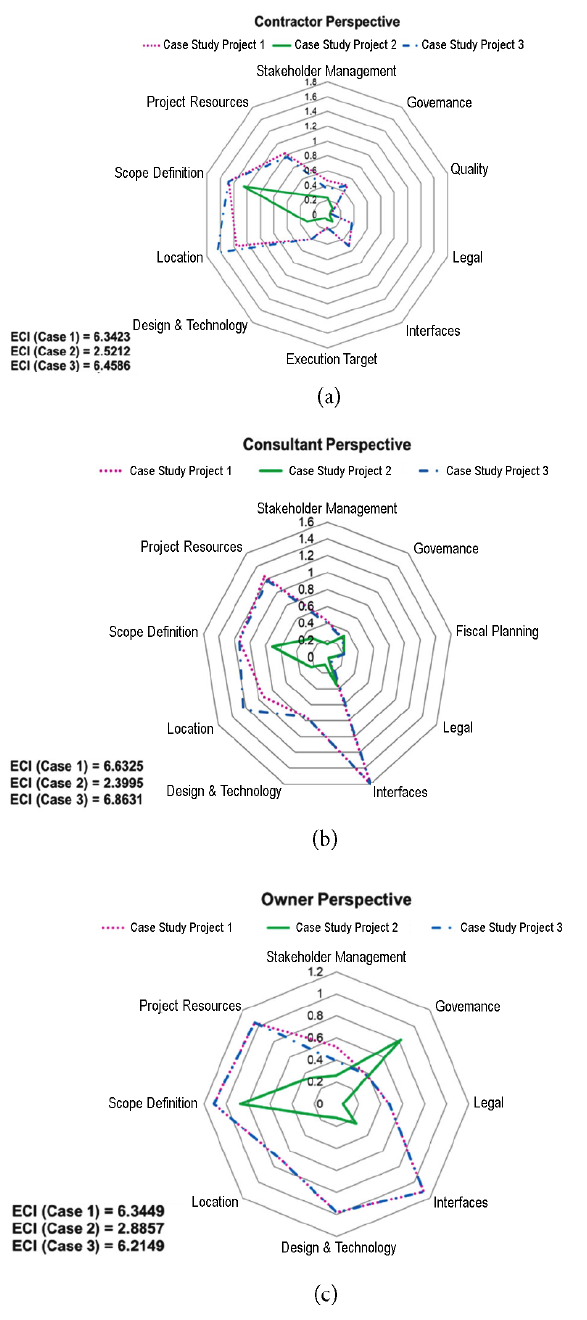
Figure 6. Comparison of weighting of complexity categories in aspect of three primary stakeholders associated with three case study projects: (a) Contractor perspective, (b) Consultant perspective, (c) Owner